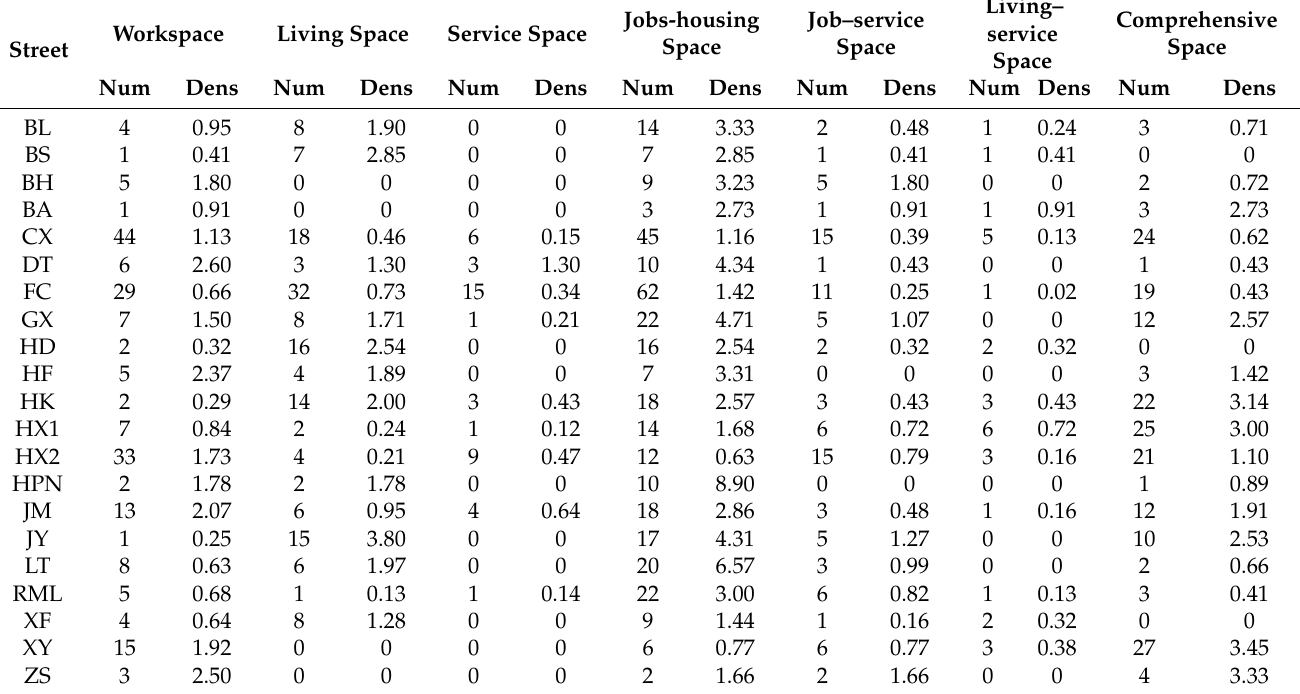
Table 7. Statistics on the number and density (/km 2 ) of street land